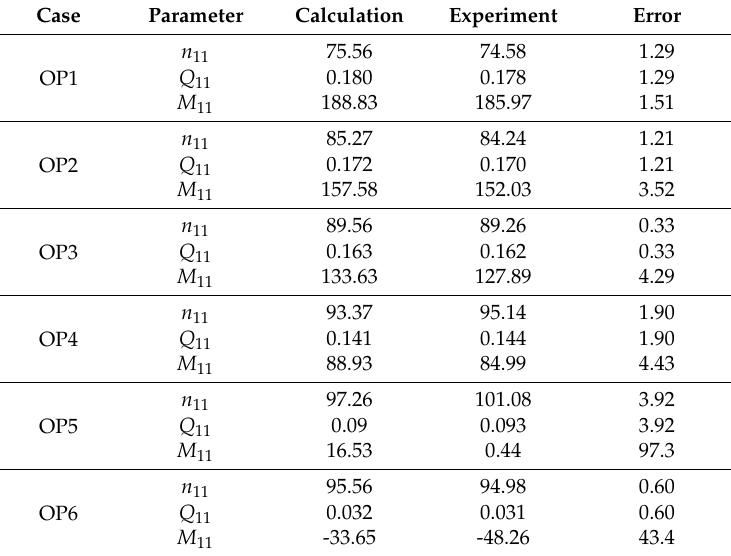
Table 6. Investigated operating points and their values of n 11 , Q 11 , and M 11 .